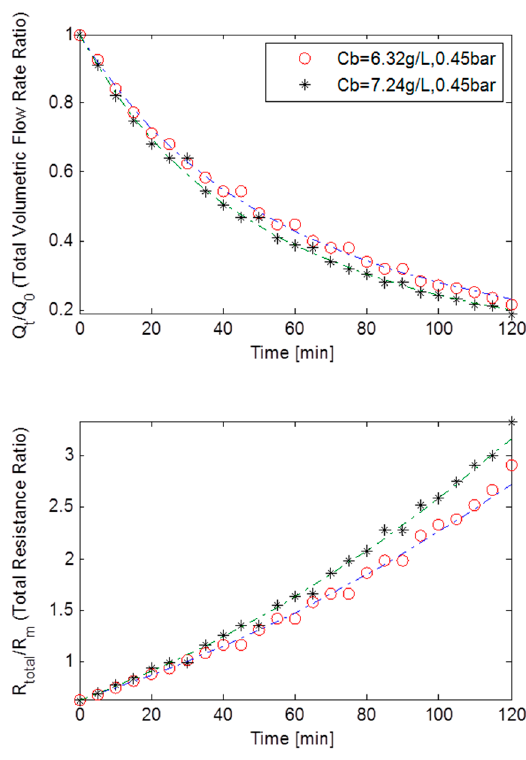
Figure 6. Flux decline and total resistance for TMP step of 45 kPa for the rotating MBR system RPU-185 with best model fits.